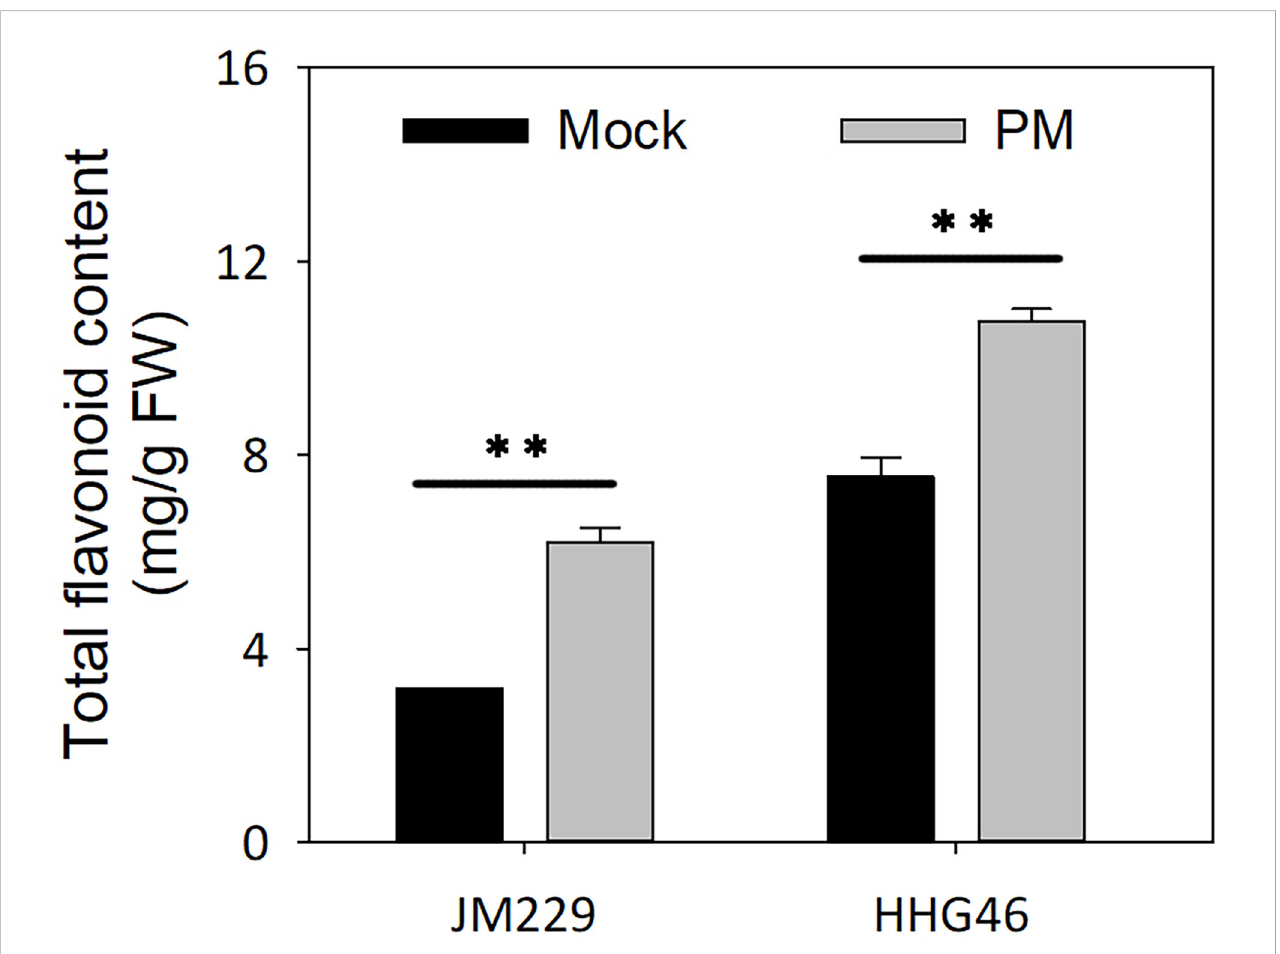
FIGURE 5 Total fl avonoids content of wheat cv. Jimai229 and HHG46 under mock and PM conditions. Error bars represent mean standard deviation of triplicate experiments. **, mean values differ signi fi cantly at the 1% probability level. FW, fresh weight; PM, powdery mildew-inoculated